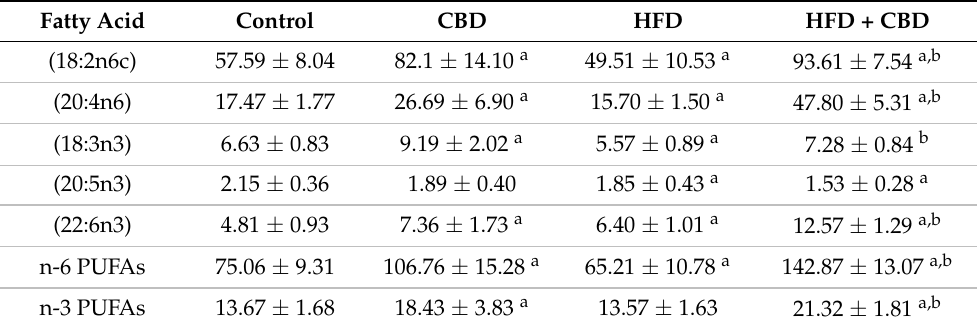
Table 1. Polyunsaturated fatty acids (PUFA) content in the FFA fraction (nmol/g of wet tissue) in the white gastrocnemius muscle in the control (standard diet) and high-fat diet (HFD) groups after two-week cannabidiol (CBD)